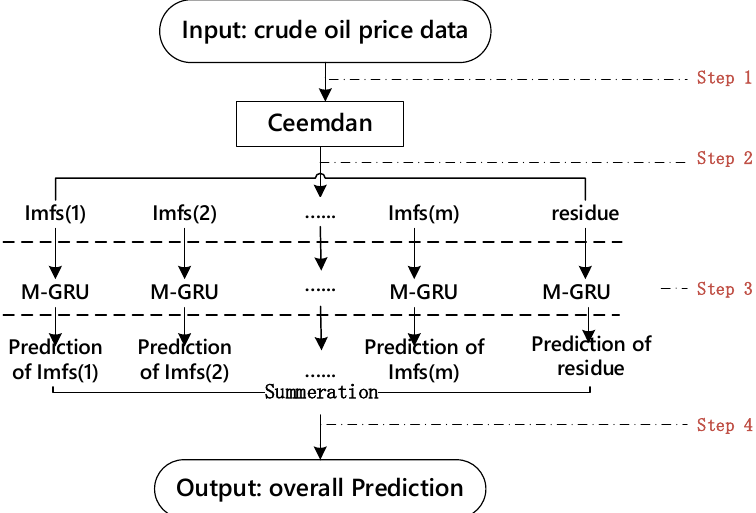
Figure 5. CEEMDAN-based Multi-layer Gated Recurrent Unit Networks (CEEMDAN-ML-GRU). This approach adopts a strategy of “divide and process”, which transforms a complicated issue into Several simple issues, and processes them independently.